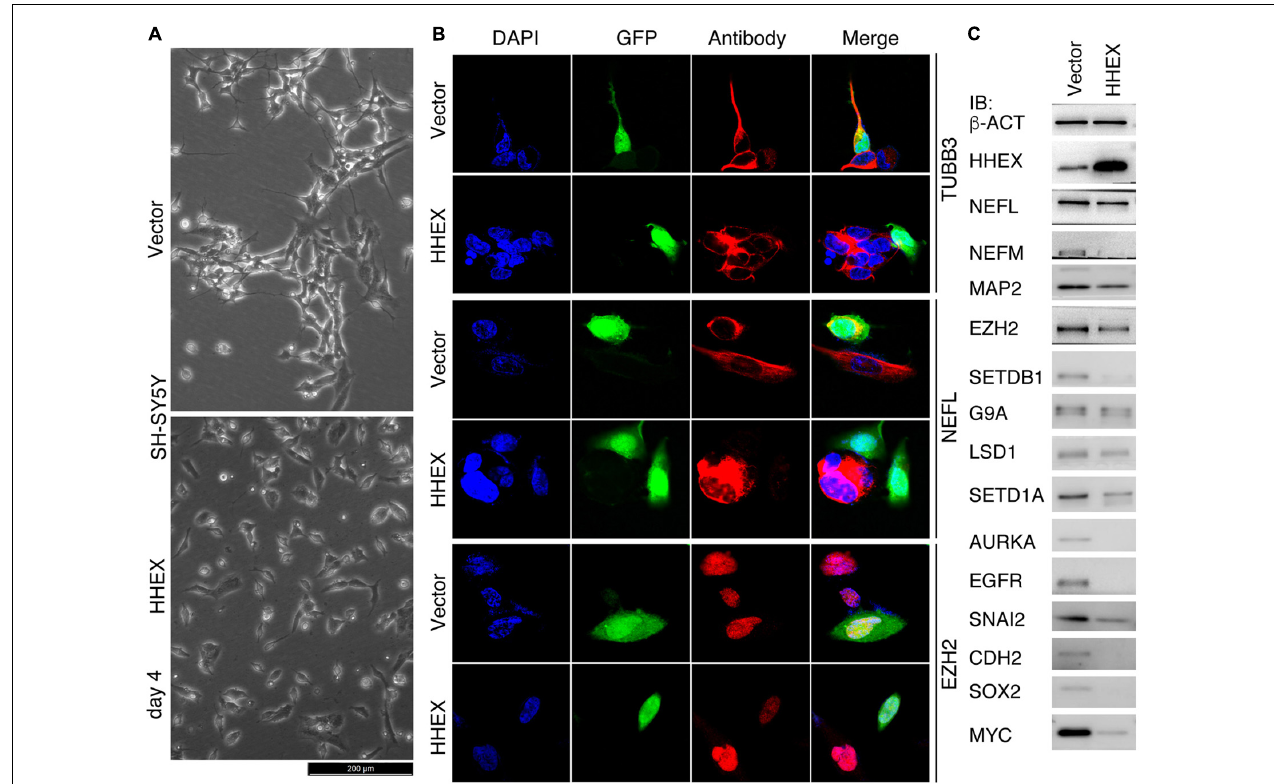
FIGURE 1 | Suppressive effect of HHEX on the neural feature of SH-SY5Y cells. (A) Phenotypic alteration of SH-SY5Y cells in response to enforced expression of HHEX after 4 days of virus infection. Cells infected with lentivirus derived from empty vector were used as control (Vector). (B) IF detection of expression of neuronal and neural stemness proteins in cells with enforced HHEX expression. Cell nuclei were counterstained with DAPI. (C) IB detection of expression of a series of proteins in response to HHEX expression.